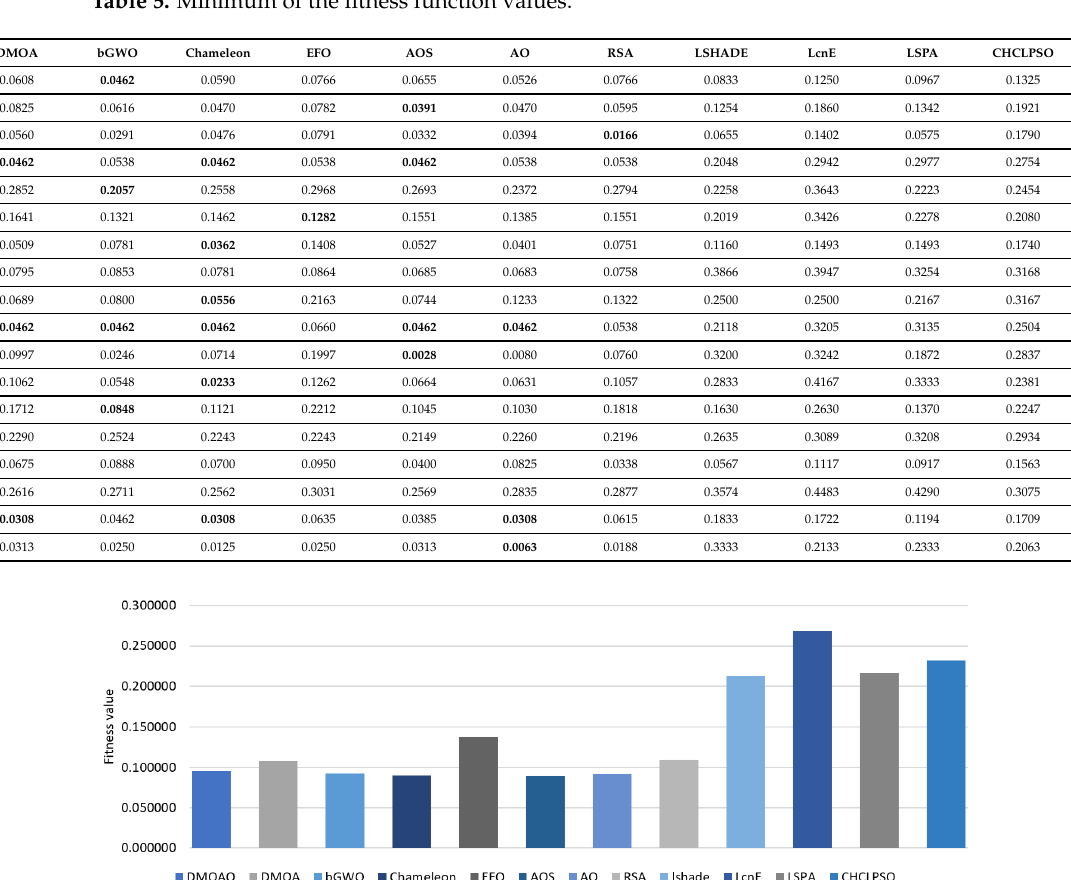
Figure 4. Average of minimum values of the fitness function. Table 6 records the results of the worst results of the fitness function values for the compared methods. Based on these, the proposed DMOAQ showed good Max